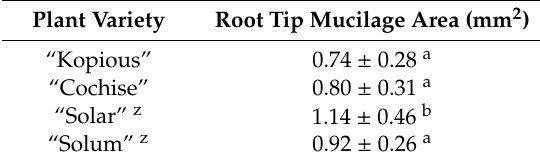
Table 1. Increased root tip mucilage area in drought tolerant z barley varieties.